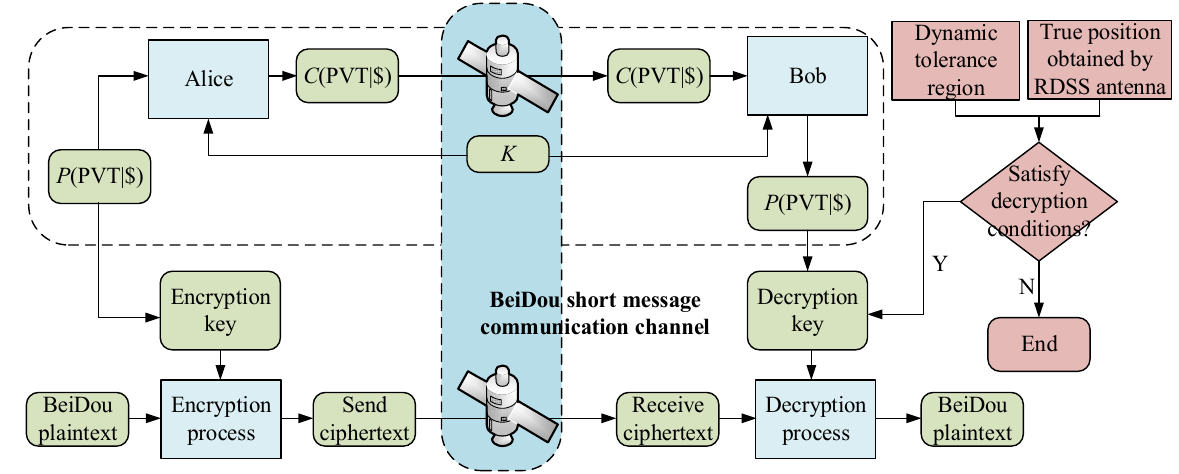
Figure 6. Flow chart of the BeiDou short-message encryption scheme considering the dynamic tolerance region.